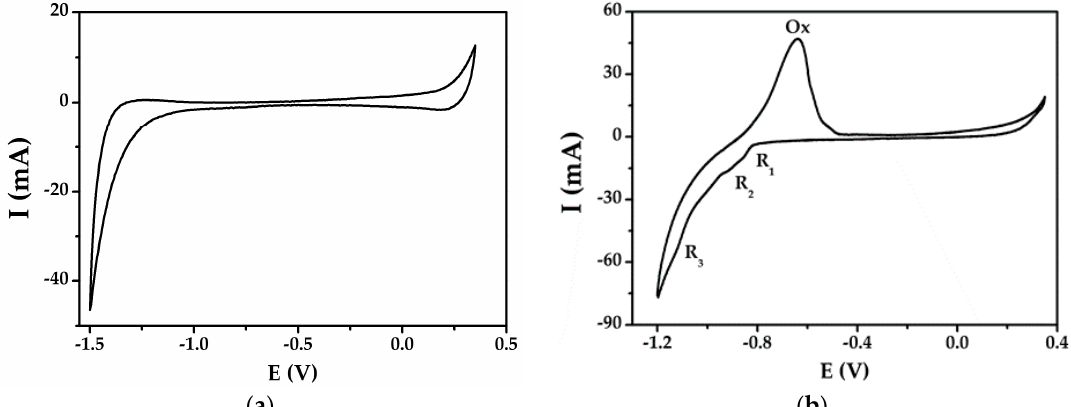
Figure 1. Cyclic voltammograms recorded on a molybdenum electrode in the melts: ( a ) NaCl ‐ KCl ‐ Na 2 MoO 4 ( С Na ₂ MoO ₄ = 3.58 × 10 − 4 mol ∙ cm − 3 ), and ( b ) NaCl ‐ KCl ‐ Li 2 CO 3 ‐ Na 2 MoO 4 ( С Li ₂ CO ₃ = 2.8 × 10 − 4 ( a ) NaCl-KCl-Na 2 MoO 4 ( C Na = 3.58 × 10 − 4 mol · cm − 3 ), and ( b ) NaCl-KCl-Li 2 CO 3 -Na 2 MoO 4 2 MoO 4 mol ∙ cm − 3 , С Na ₂ MoO ₄ = 5.47 × 10 − 4 mol ∙ cm − 3 ). Electrode surface area 0.238 cm 2 , potential sweep rate 0.1 ( C Li = 2.8 × 10 − 4 mol · cm − 3 , C Na = 5.47 × 10 − 4 mol · cm − 3 ). Electrode surface area 0.238 cm 2 , 2 CO 3 2 MoO 4 V ∙ s − 1 , temperature 1023 K, platinum quasi ‐ reference electrode. potential sweep rate 0.1 V · s − 1 , temperature 1023 K, platinum quasi-reference